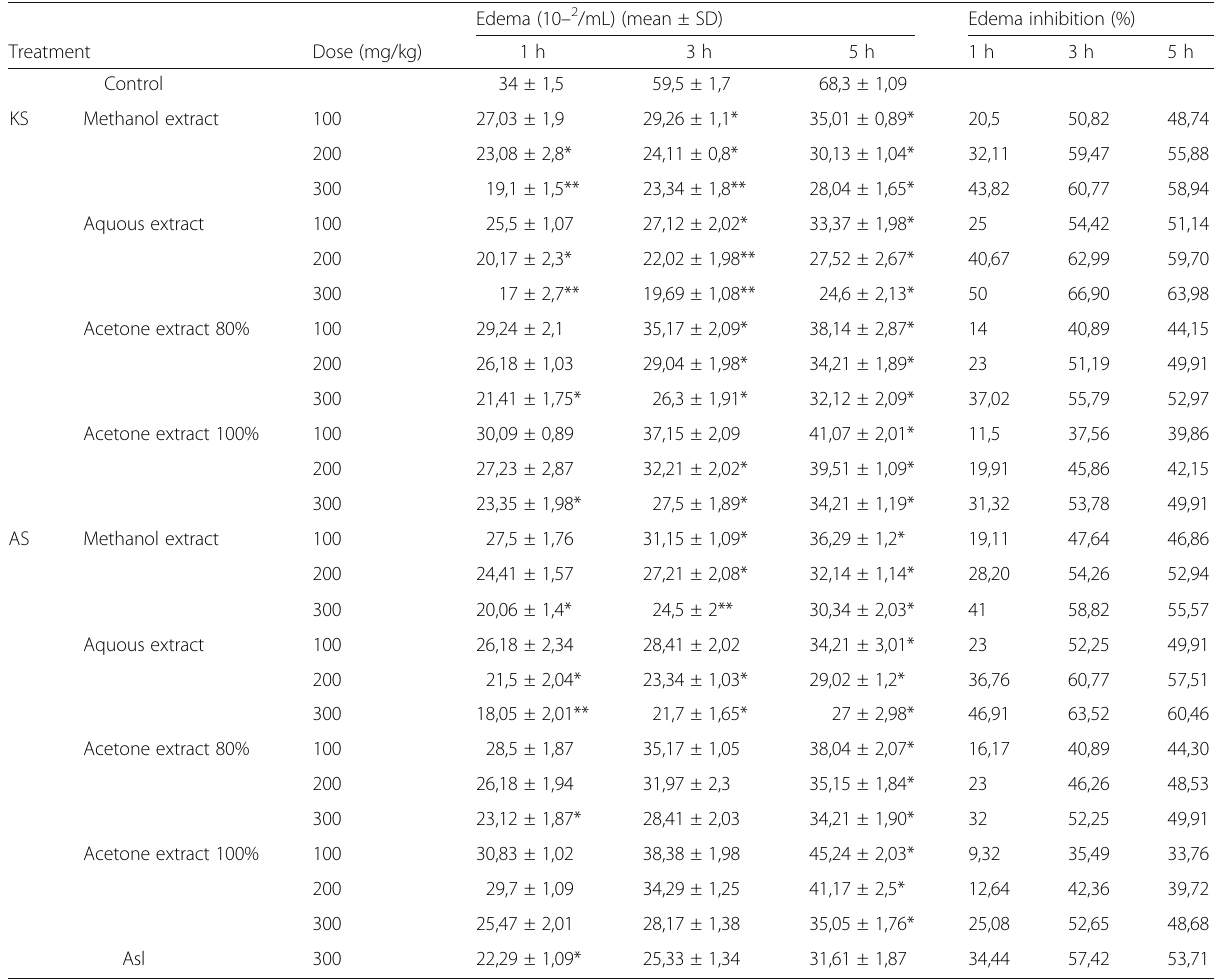
Table 4 Effect of solvents extraction on in vivo anti-inflammatory activity of both date seeds